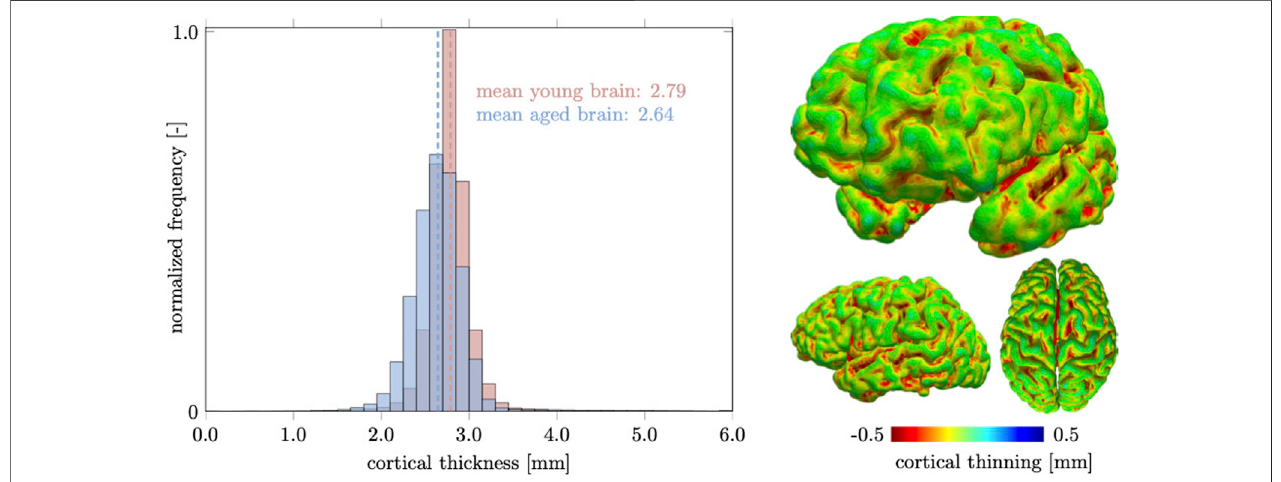
FIGURE 8 | We measure cortical thickness changes in the healthily aging brain and observe a clear difference between increased sulcal thinning in comparison to gyri that remain nearly unchanged. Only few locations are predicted to thicken and are located in deep gray matter locations. Overall the mean cortical thickness decreases from 2.79 mm in the young brain to 2.64 mm in the aged